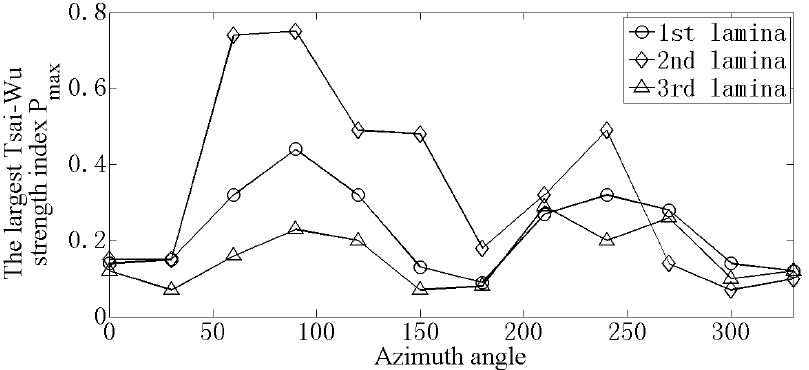
Figure 8. Largest strength index for di ff erent azimuth